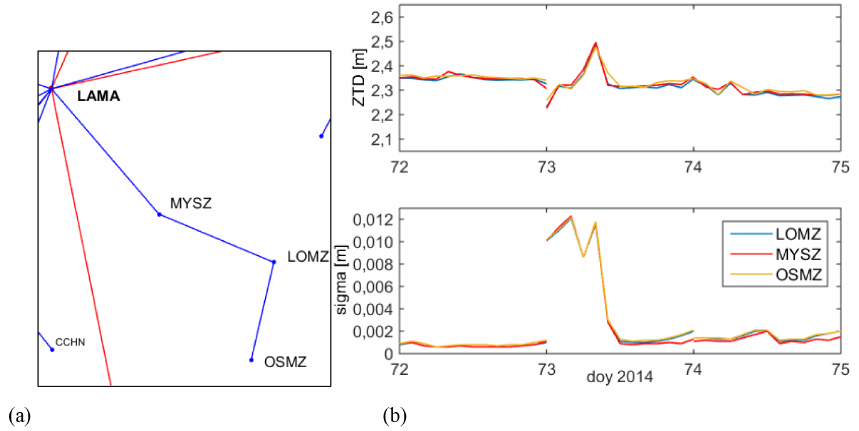
Figure 4. Example of common mode biases in ZTD affecting a cluster of stations (MYSZ, LOMZ, OSMZ) due to disconnection from the reference network. (a) In this network design the group of stations is connected to the main network through a single baseline MYSZ–LAMA. (b) A data gap at station LAMA on day 73 provokes a common mode bias at all stations of the group.